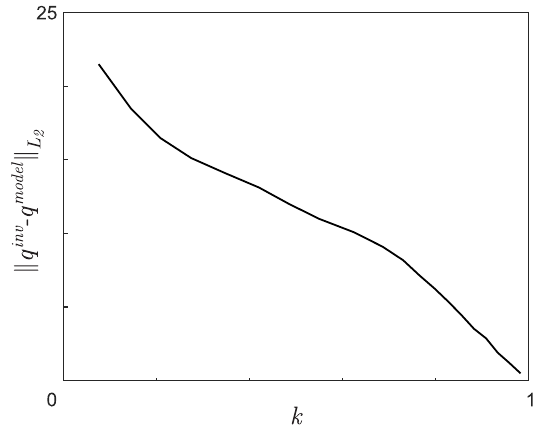
Figure 6. Dependence of the accuracy of reconstruction the approximate solution q inv ( x ) on the part of the region k passed through by the reaction front during its experimental observations (the case of ε = 10 − 2.5 , δ =